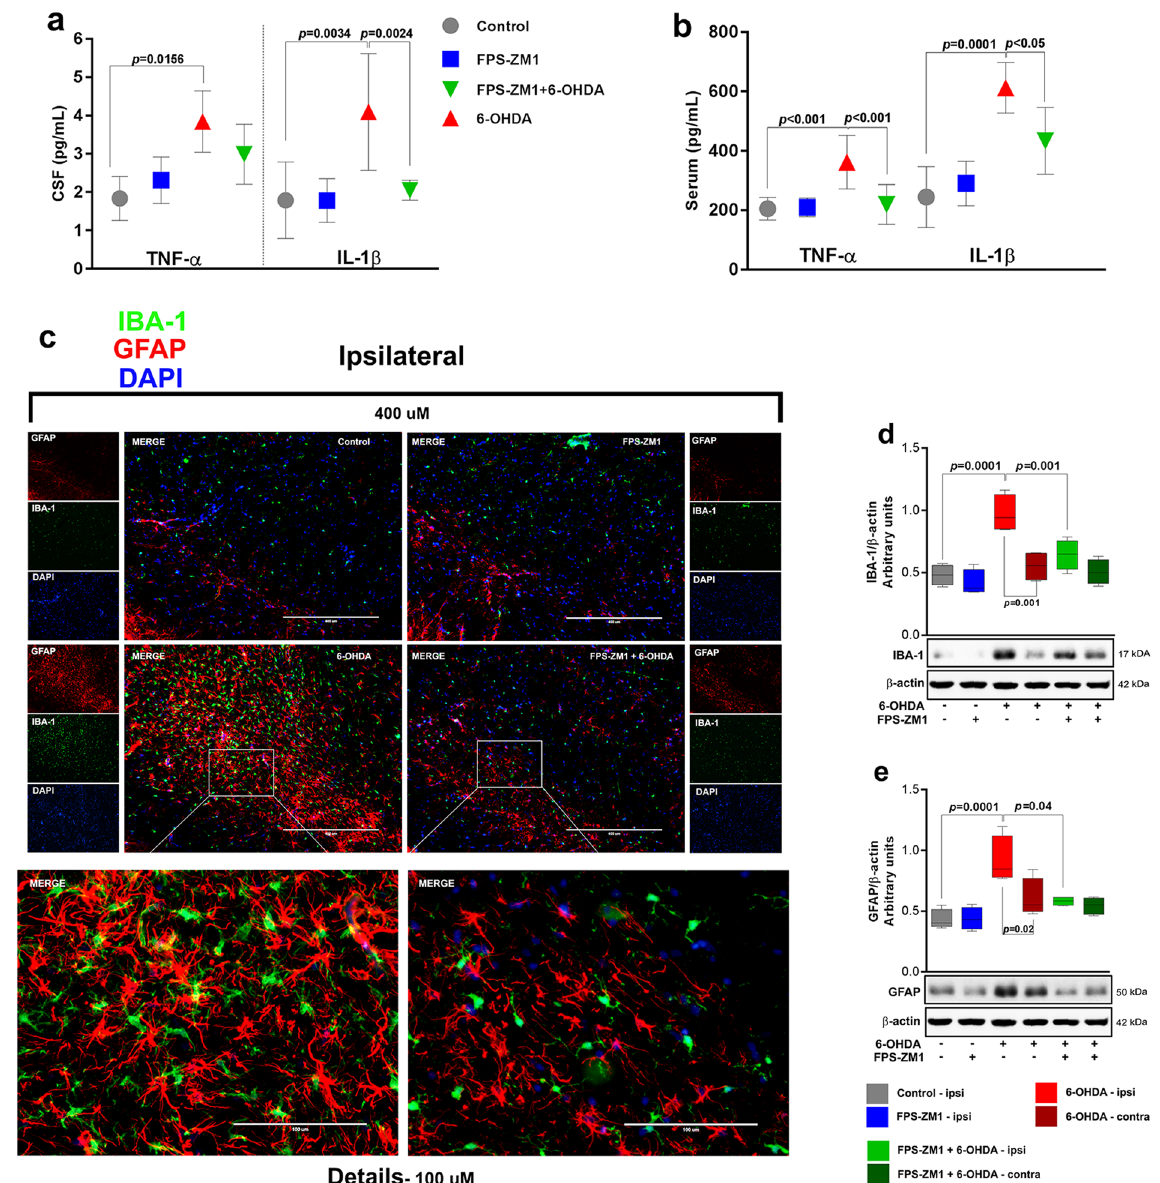
Figure 5. FPS-ZM1 protected rats from 6-OHDA-induced neuronal inflammation. CSF and serum were analyzed by ELISA assay 15 days after 6-OHDA administration. ( a ) Cerebrospinal fluid was analyzed for TNF- α and IL-1 β . TNF- α and IL-1 β levels are expressed in pg/mL. ( b ) Serum samples were analyzed for TNF- α and IL-1 β . ( c ) Representative immunofluorescence images of SN co-immunostained for IBA-1, GFAP and DAPI ( n = 10 per group). The ipsilateral sides are shown. The microscopy images were taken with 400 μ m of magnification and the squares represents the location of the approximation of 100 μ m. Representative western blots and quantification of ( d ) IBA-1 ( n = 6 per group) and ( e ) GFAP ( n = 6 per group). Each color in the graph represents a group and a brain location: gray - control/ipsilateral side; blue - FPS-ZM1/ipsilateral side; red - 6-OHDA/ipsilateral side; dark red - 6-OHDA/green - FPS-ZM1 + 6-OHDA/ipsilateral side; dark green - FPS-ZM1 + 6-OHDA/contralateral side. Values represent mean ± SD. One-way analysis of variance and Bonferroni Multiple Comparison post-hoc test were applied to all data. p values are embedded in the